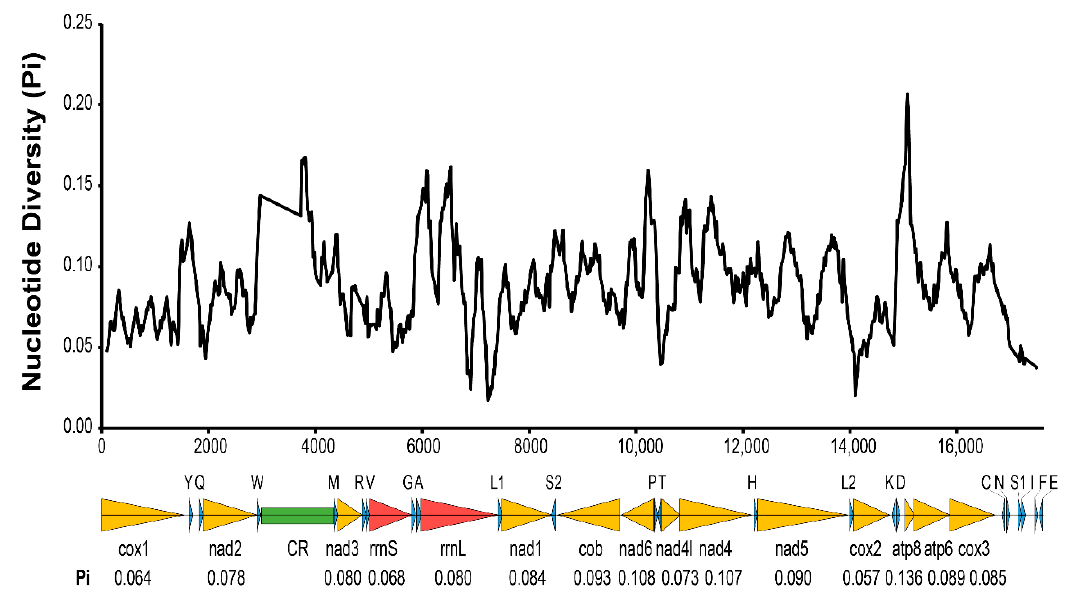
Figure 2. Nucleotide diversity (Pi) of six Trichogramma mitochondrial genomes. The x-axis indicates the position in the alignment of six mitochondrial genomes. The black wave line indicates the average nucleotide diversity of sliding windows. The window size was 200 bp with a step size of 20 bp. The arrows below the graph indicate 37 mitochondrial genes. Yellow indicates mitochondrial protein-coding genes. Red indicates mitochondrial ribosomal RNAs. Blue indicates mitochondrial tRNA. Green indicates the control region. The average Pi of protein-coding genes and ribosomal RNAs are labeled under each gene name.